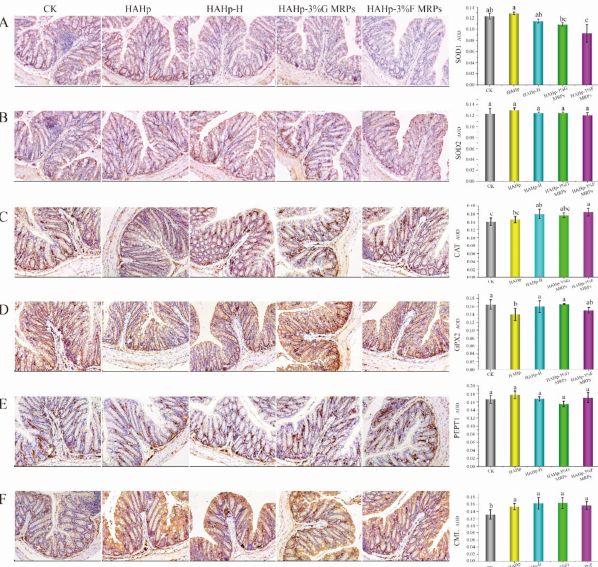
Figure 4. Protein expressions of Cu/Zn-SOD (SOD1), Mn-SOD (SOD2), catalase (CAT), glutathione peroxidase 2 (GPX2), oligopeptide transporter 1 (PEPT1), and N ε -carboxymethyllysine (CML) found via immunohistochemistry (IHC) (100 × ) analysis of the colon tissues of mice after 30 days of oral administration of HAHp, HAHp-H, HAHp-3%G MRPs, and HAHp-3%F MRPs compared to the CK. ( A ) SOD1, ( B ) SOD2, ( C ) CAT, ( D ) GPX2, ( E ) PEPT1, and ( F ) CML. In average optical density (AOD) analysis, different lowercase letters represent significant differences ( p <